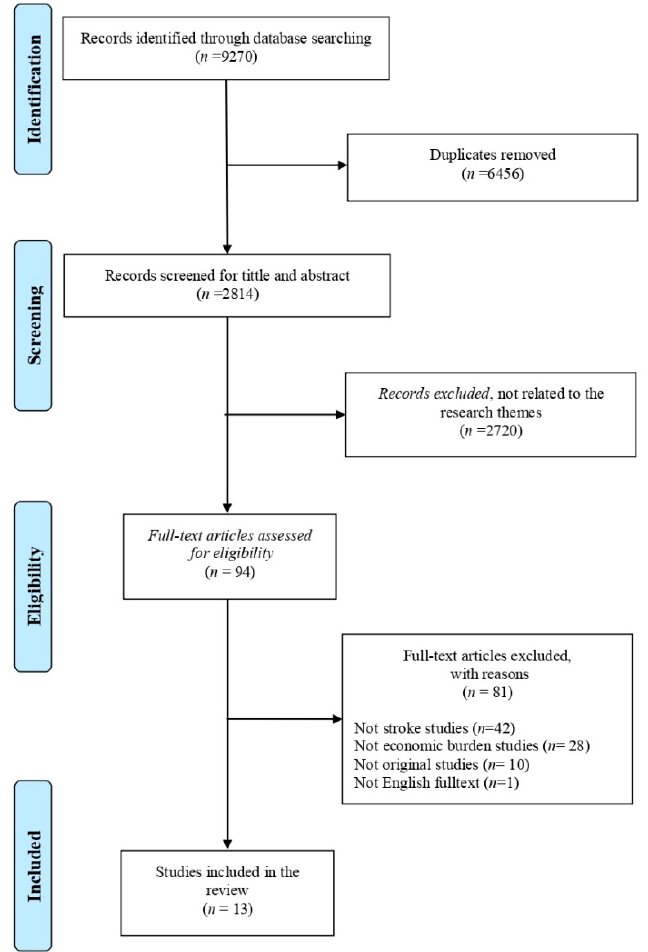
Figure 1 . PRISMA flowchart. Figure 1. PRISMA